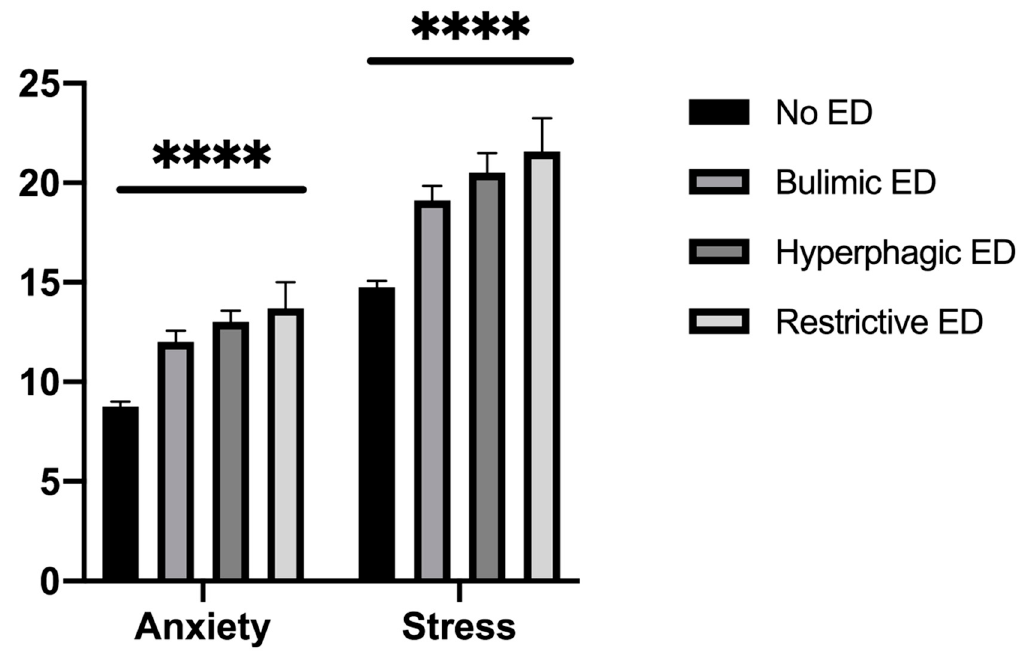
Figure 2. Score of anxiety and stress according to eating disorder ( n = 1493). ****: p < 0.0001.